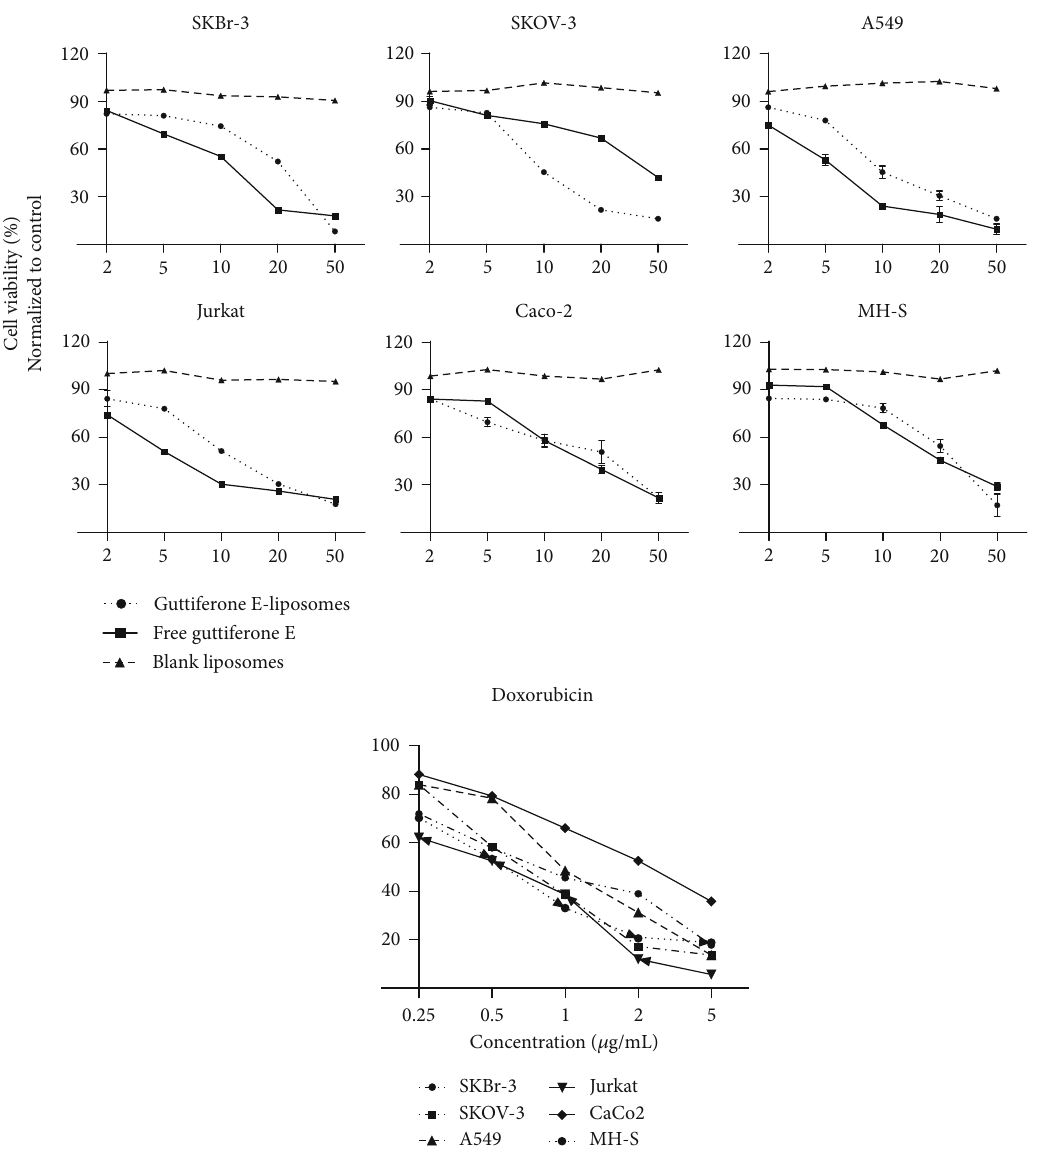
Figure 3: Guttiferone E-loaded liposome inhibition of the growth of human cancer cell lines. Cell viability (MTT) assays were performed using equivalent dosages of free guttiferone E dissolved in DMSO, guttiferone E-loaded liposomes, and blank liposomes in a panel of human cancer cell lines. Table 1: IC values ( μ g/mL) of free guttiferone E and guttiferone E-loaded liposomes against human cancer cell lines. 50 Cell lines